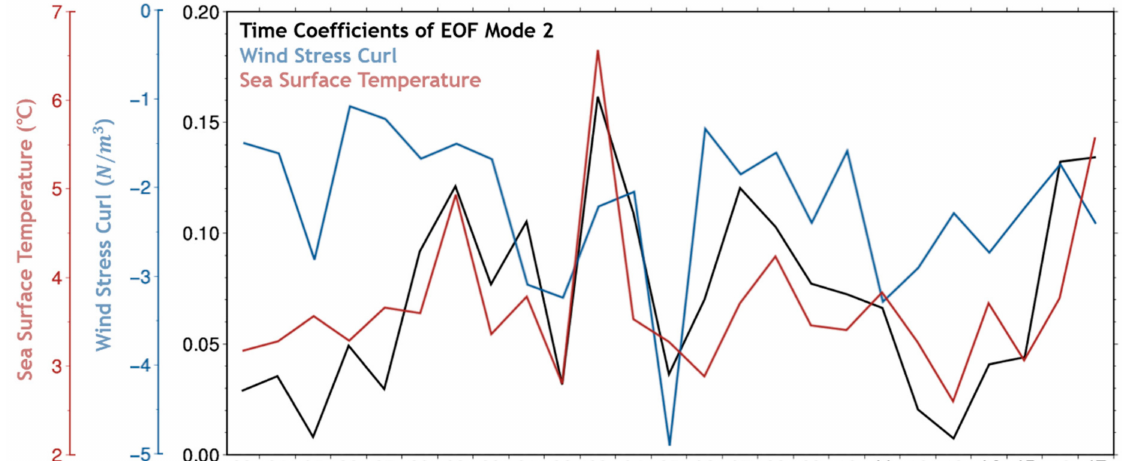
Figure 5. Time-series of temporal evolution of EOF mode 1 (black line) for October–November–December (OND) when the mesoscale features are manifested in the NES, OND wind stress curl (blue line) spatially averaged over the region with positive SSH anomalies (red box in Figure 1), and OND SST difference (red line) between the regions with positive and negative SSH anomalies (blue box in Figure